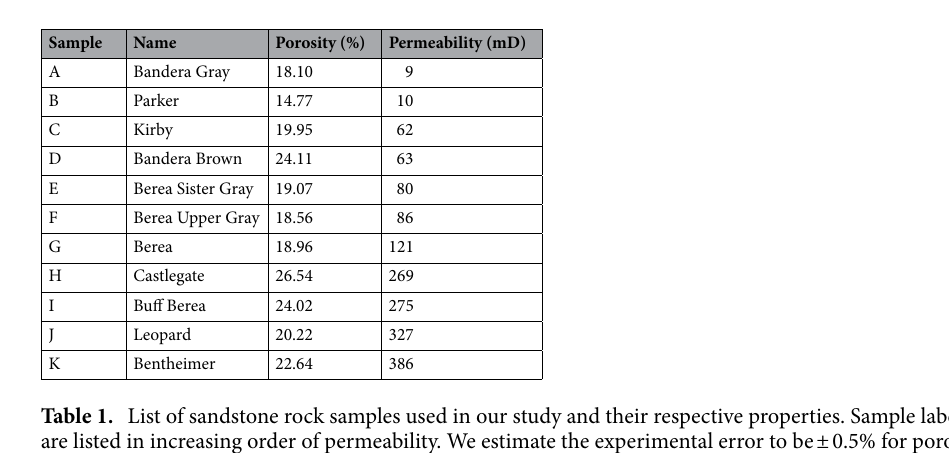
Figure 1. Conception of permeability and porosity determination in rock samples. ( a ) Permeability and porosity measurements are performed at lab scale. However, computational simulations are performed with microscopic network representation at pore scale. 3D visualization created using Blender v2.92.0 software. ( b ) Pore scale representation of a rock sample derived from an X-ray microtomography with 1000 voxels of 2.25 µm along each side, resulting in an overall side length of 2.25 mm. 3D visualization created using ParaView v5.9.0 software. ( c ) The experimental porosity–permeability plot of containing all rock samples. ( d ) Representative grayscale images extracted from the data cube of the least porous (B), least permeable (A), most porous (H) and most permeable (K) rock sample, respectively, exhibit the microstructural variation occurring at pore scale. The white scale bar at the lower right corner of each image represents 500 µm.